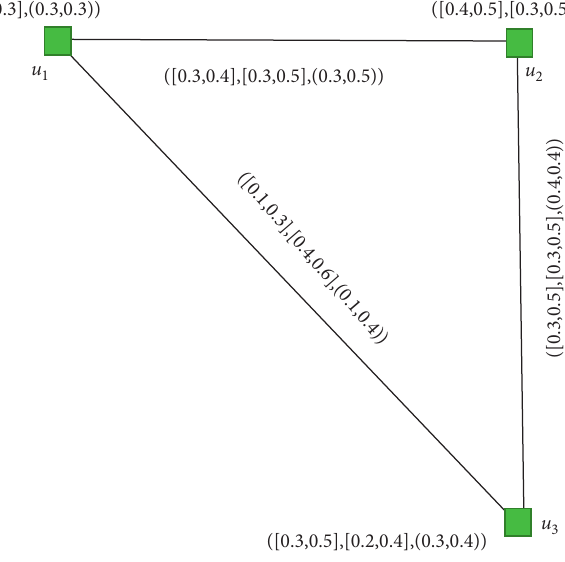
Figure 18: Union of cubic intuitionistic fuzzy